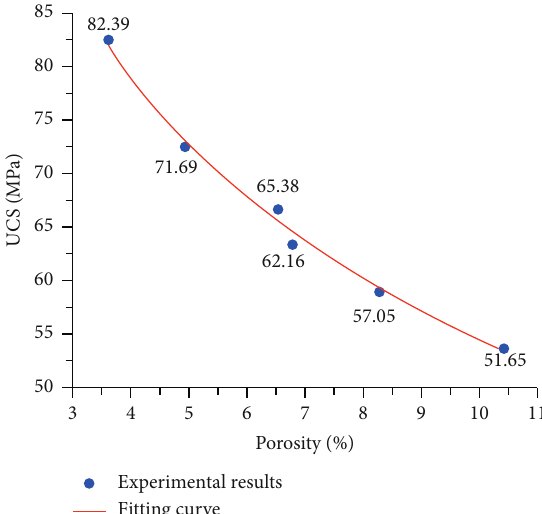
Figure 9: Relationship between UCS and porosity.